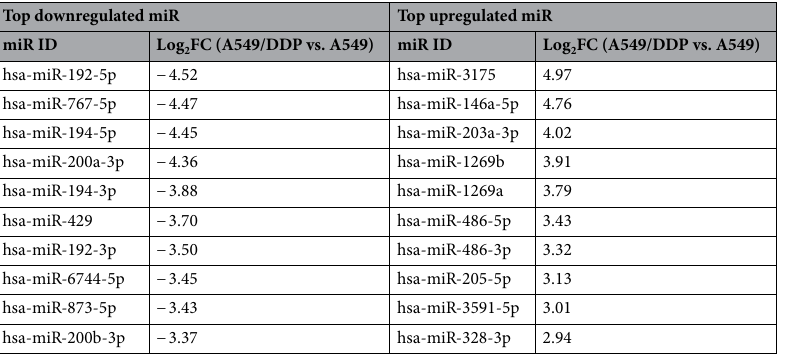
Table 1. Top 10 down- and up- regulated miRNAs in A549/DDP vs. A549 cells, as were detected by